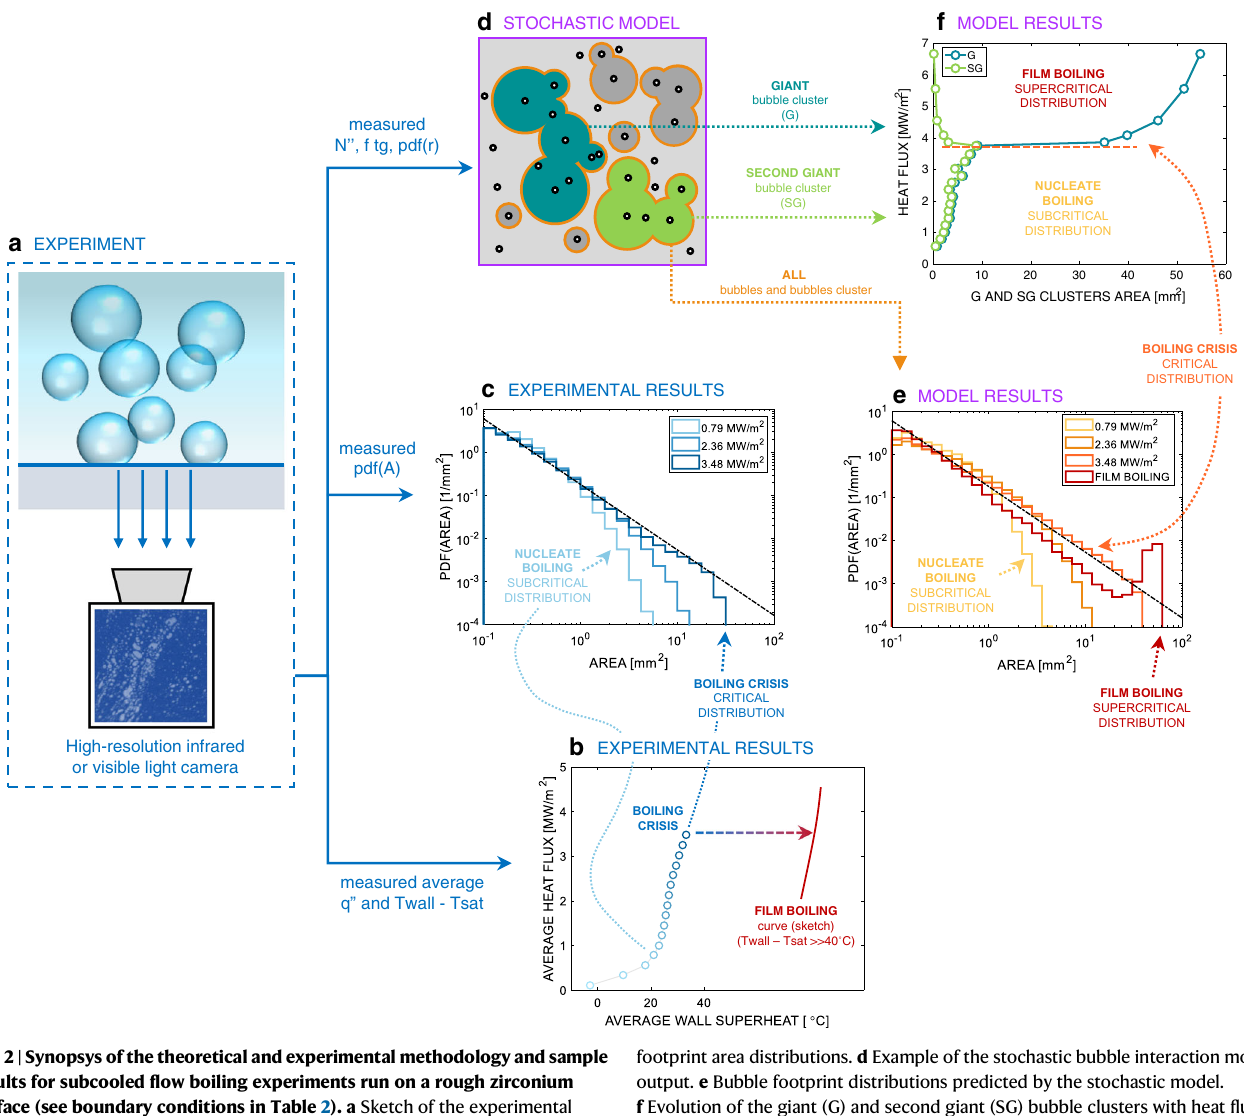
footprint area distributions. d Example of the stochastic bubble interaction model output. e Bubble footprint distributions predicted by the stochastic model. f Evolution of the giant (G) and second giant (SG) bubble clusters with heat fl ux predicted by the model, showing that a power law bubble footprint area distribu- tion coincides with a bifurcation of the G and SG clusters